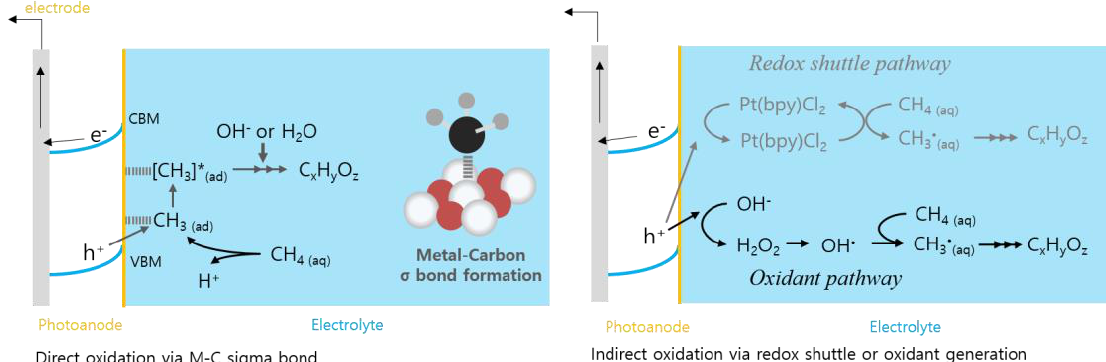
Figure 7. Direct and indirect methane oxidation mechanisms for a photoelectrochemical cell.